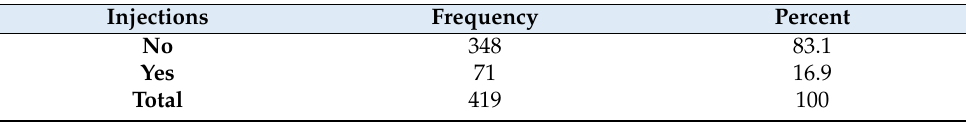
Table 2. Percentage of cases with parenteral antibiotics.